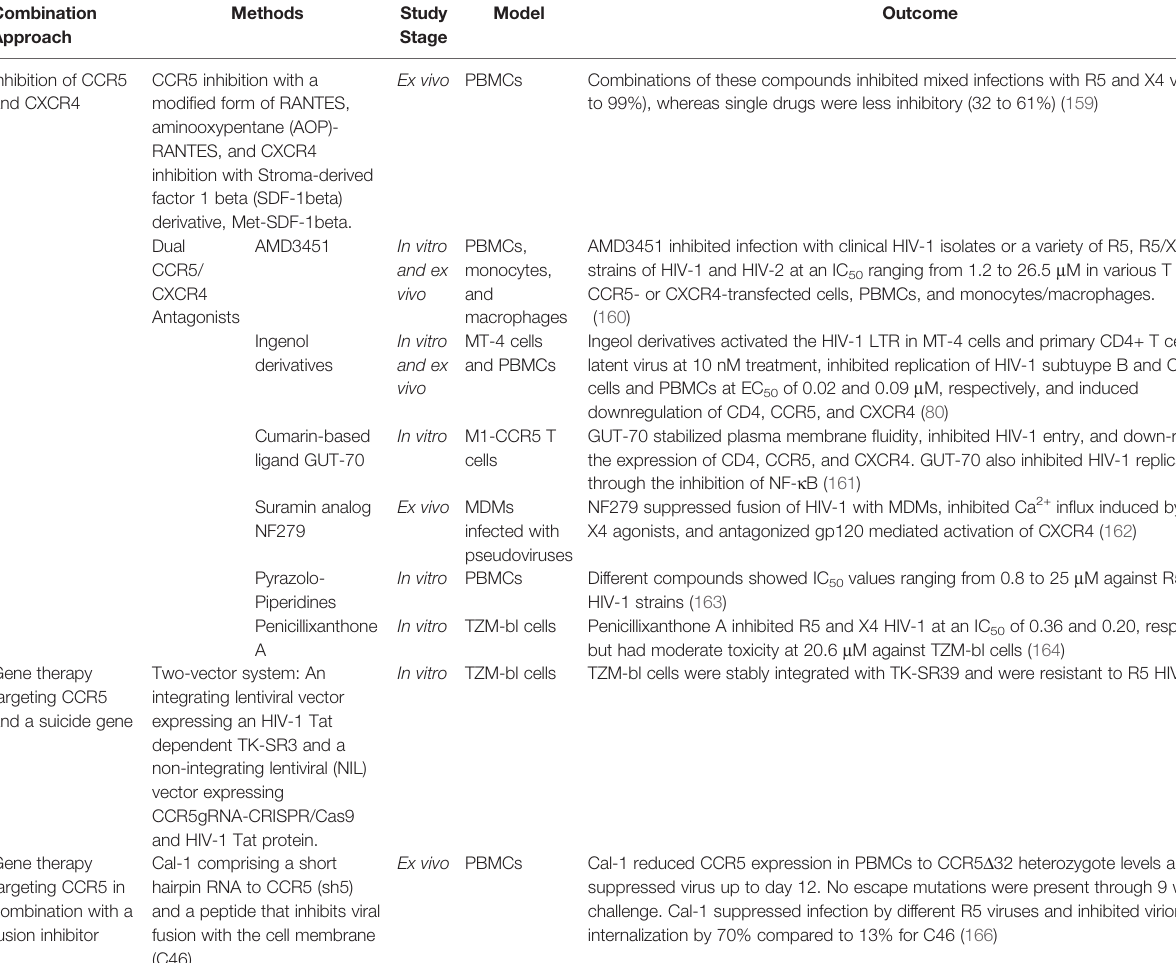
TABLE 2 | Combinatorial approaches utilizing CCR5 targeting techniques for therapy of HIV-1 infection. Combination